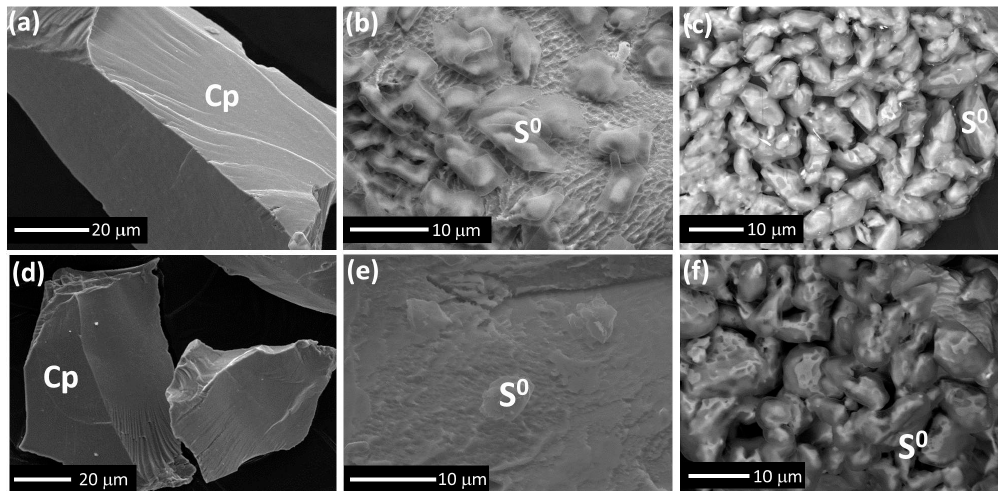
Figure 9. SEM images collected from chalcopyrite leached with 4 mmol added iron at 750 mV and 75 °C for ( a ) 1 h, ( b ) 30 h, ( c ) 72 h; without iron addition for ( d ) 1 h, ( e ) 30 h, ( f ) 72 h.